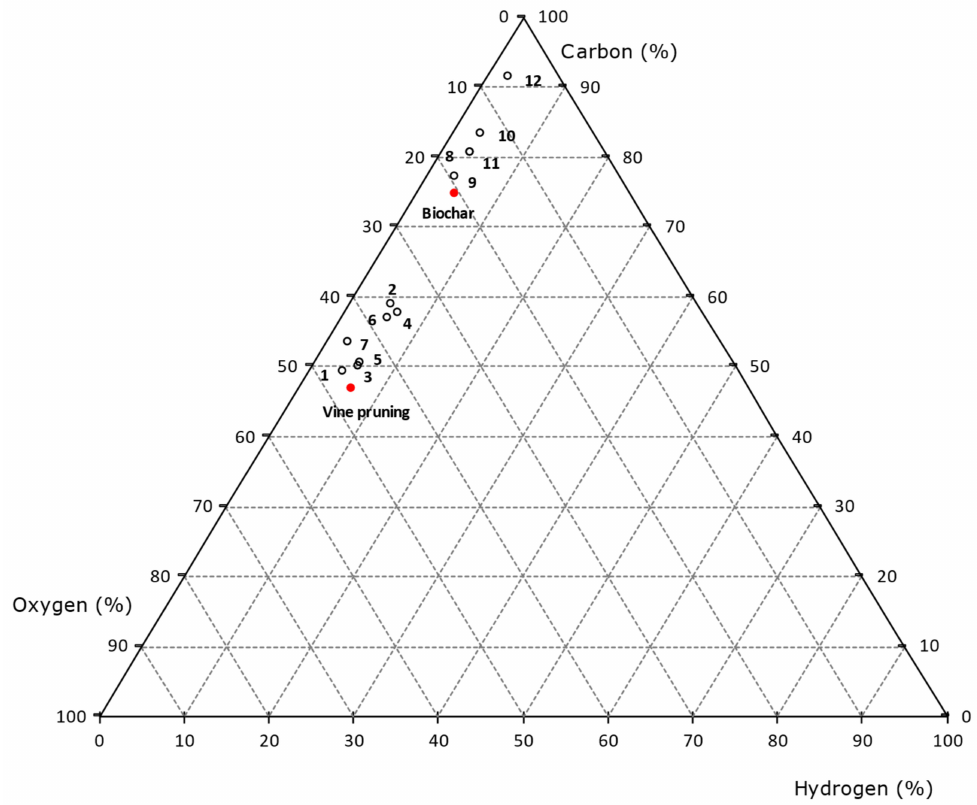
Figure 5. Triangular diagram representing CHO contents. As can be seen, the content of CHO for vine pruning is similar to those found by Nunes et al. (2020) and S á et al. (2020), both for dry and carbonized samples [26,33]. Vine pruning and biochar are the samples analyzed in the present work; samples 1 to 6 and samples 7 to 12 are, respectively, dry samples and carbonized samples from previous referred studies, as follows: 1 and 7—rice husks; 2 and 8—almond shells; 3 and 9—kiwi pruning; 4 and 10—olive pomace; 5 and 11— Pinus pinaster ; and 6 and 12— Eucalyptus globulus .